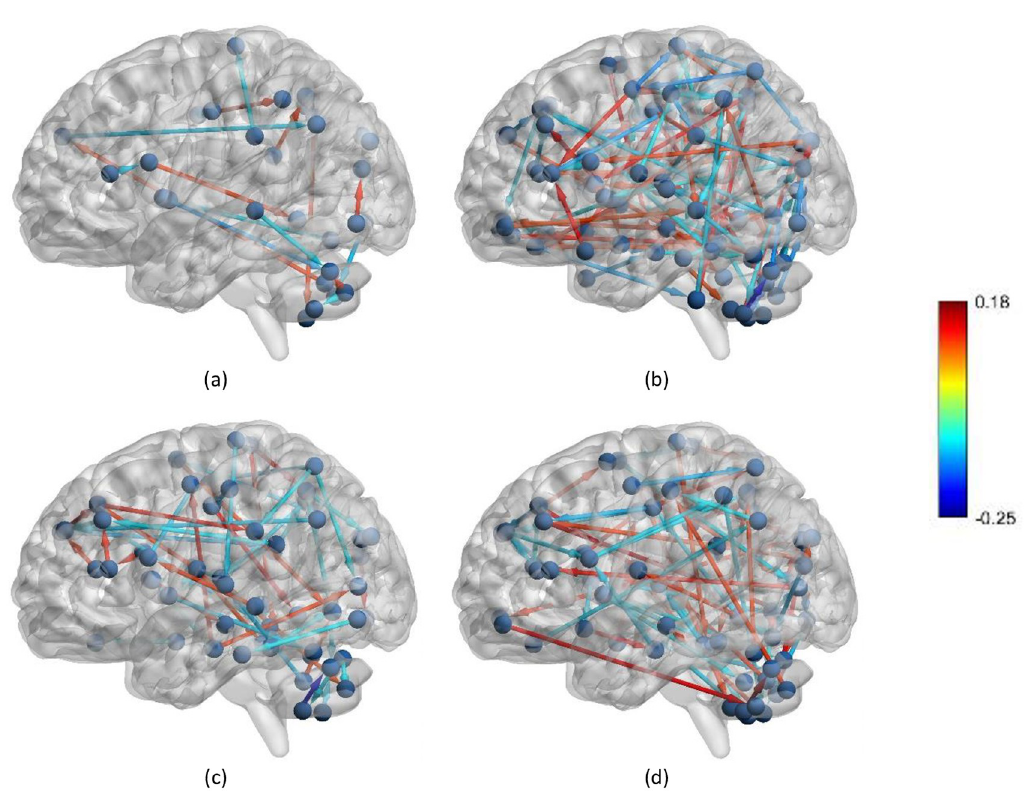
Fig 4. Brain connectivity networks for (a) CN, (b) EMCI, (c) LMCI, and (d) AD at threshold = 0.1, the color code defines the connection’s